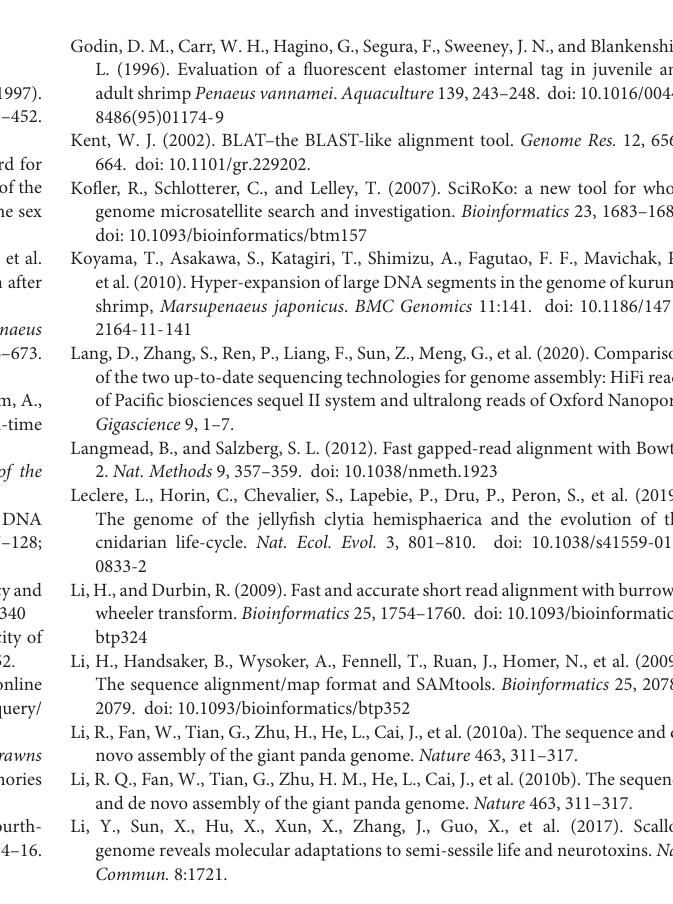
Supplementary Figure 3 | The comparison of read coverages of various genomic regions. Supplementary Table 1 | SOAPdenovo assembly of four penaeid shrimp species. Supplementary Table 2 | Statistics of genome assembly of F. chinensis using different methods. Supplementary Table 3 | Statistics of genome assembly of four penaeid shrimp